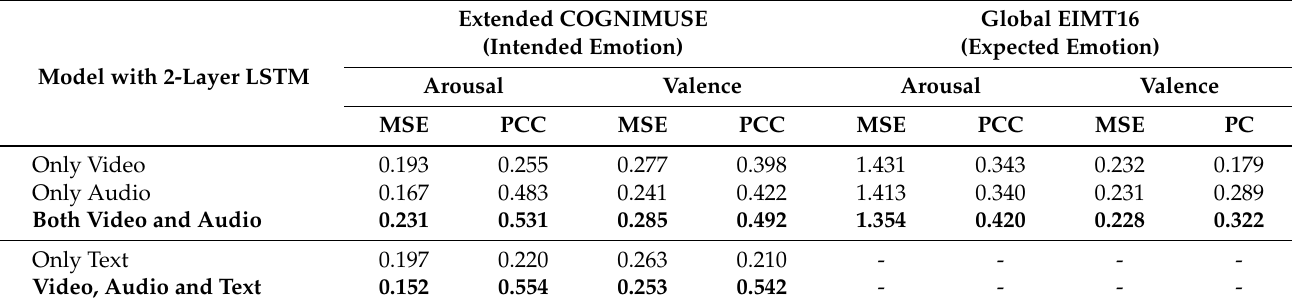
Table 7. Predicting arousal and valence directly: The performance of the two-layer LSTM structure.